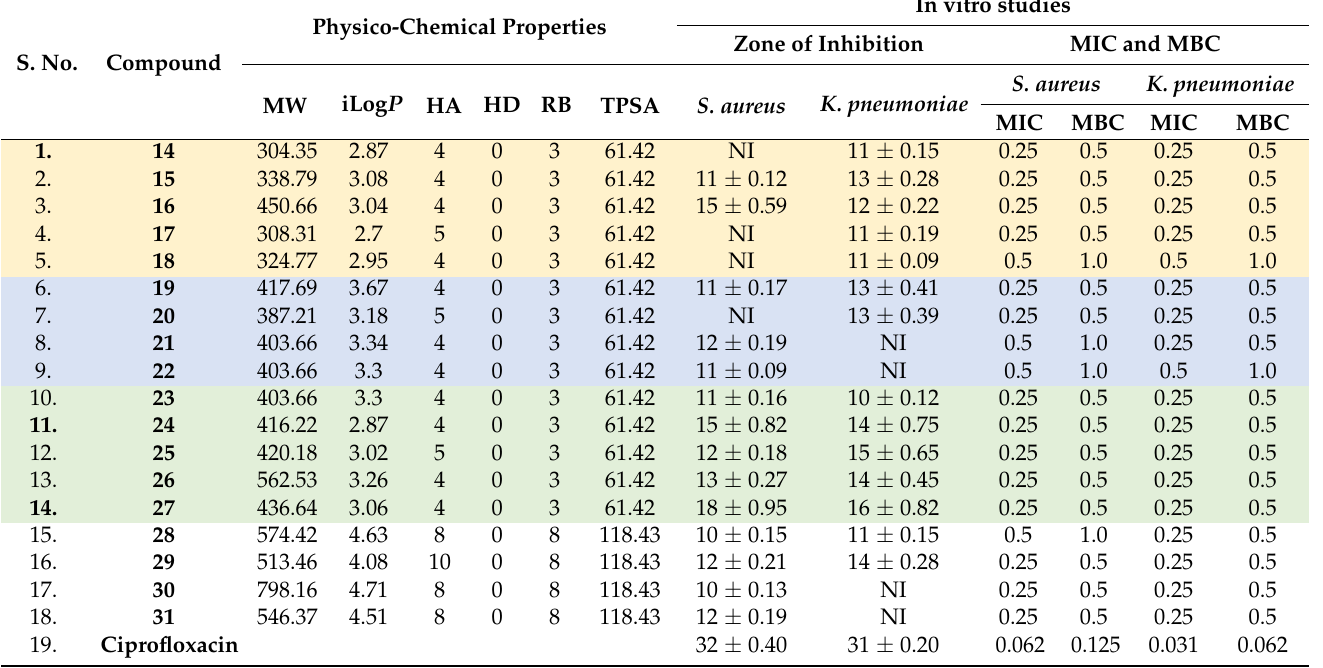
Table 2. The Physico-chemical and biological properties of pyazolo[3,4- b ]pyridine and triazole molecular hybrids.